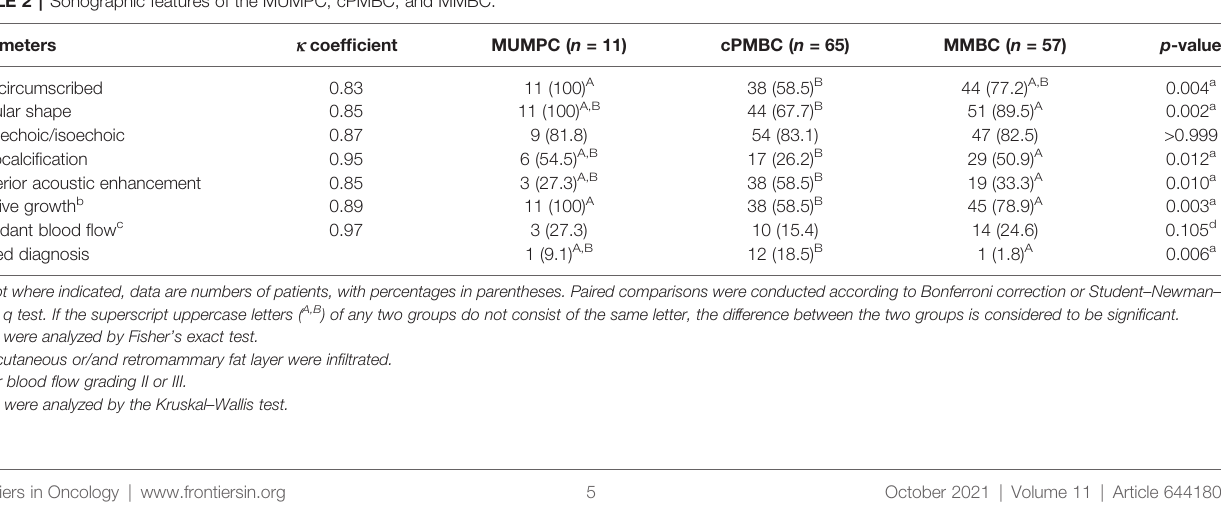
TABLE 2 | Sonographic features of the MUMPC, cPMBC, and MMBC.